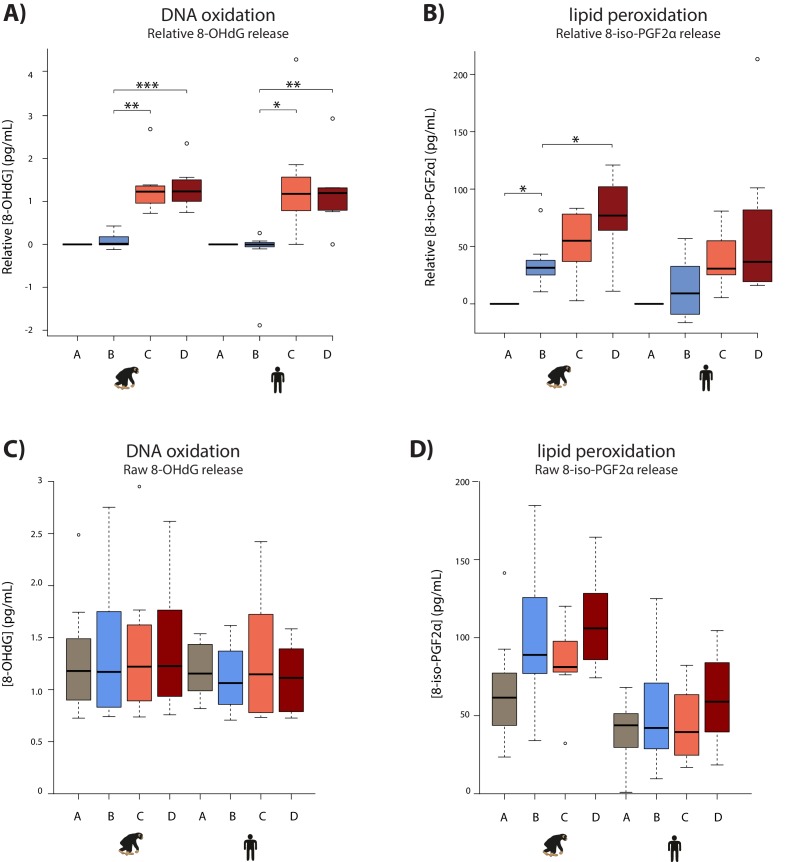
Hypoxia induces oxidative damage in both species.(A) Levels of 8-OHdG, a measure of oxidative DNA damage, in the cell culture media from each individual. Values are normalized to normoxia or hypoxia values that is A (A-A), B (B-A), C (C-B), and D (D-B). (B) Levels of 8-iso-PGF2α, a measure of lipid peroxidation, in the cell culture media from each phase of the experiment in each species as in (A). (C) Raw values associated with 8-OHdG release. (D) Raw values associated with 8-iso-PGF2α release. Values from the baseline normoxic (brown), hypoxic (blue), short-term re-oxygenation (coral), and long-term re-oxygenation (dark red) conditions are shown in each species. Asterisk denotes a significant difference between conditions (*p<0.05, **p<0.005, ***p<0.0005).